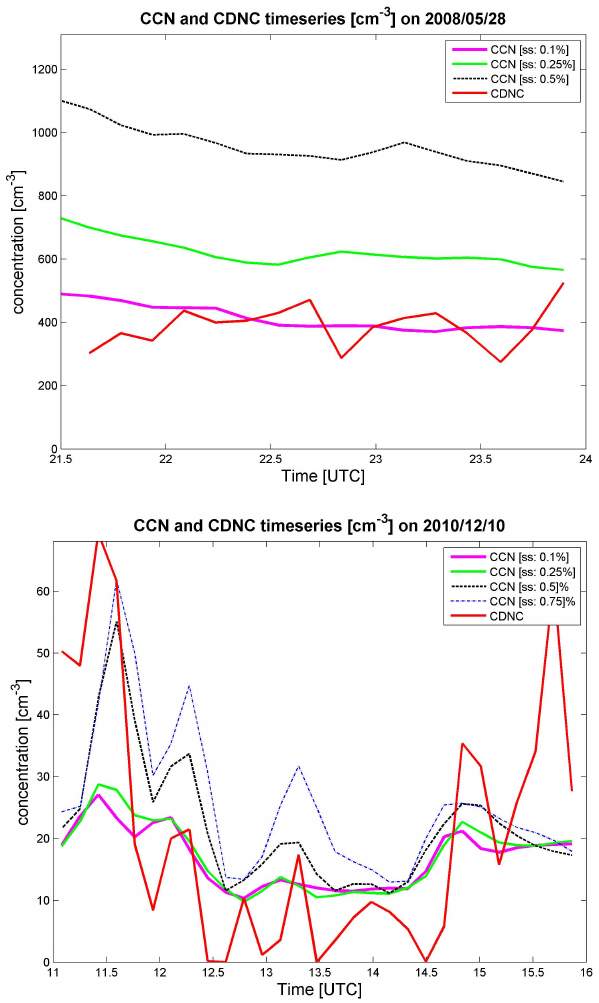
Fig. 6. Continental (left) and marine (right) case: comparison be- tween CDNC and CCN at supersaturation levels of 0.1%–0.25%– 0.5%–0.75%. Temporal resolution is